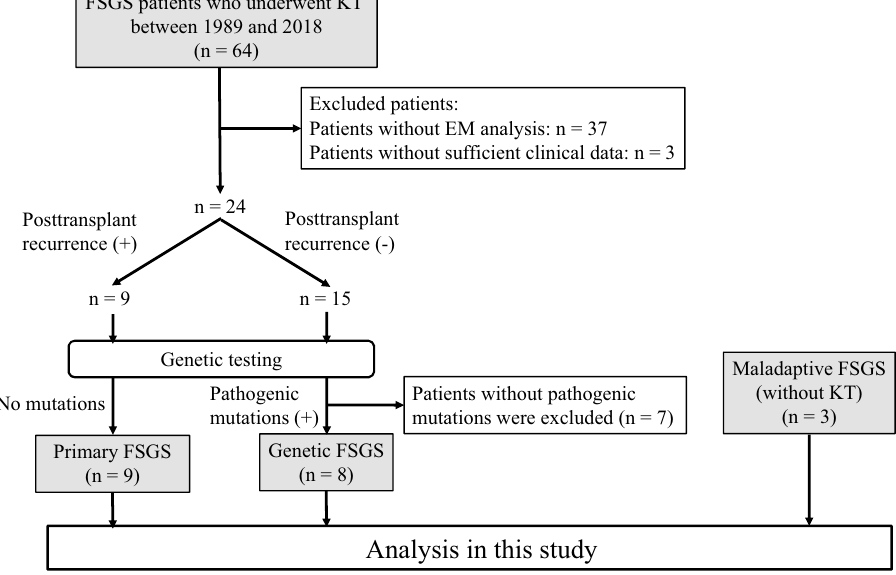
Figure 4. Study population in the present study. FSGS, focal segmental glomerulosclerosis; KT, kidney transplantation; EM, electron